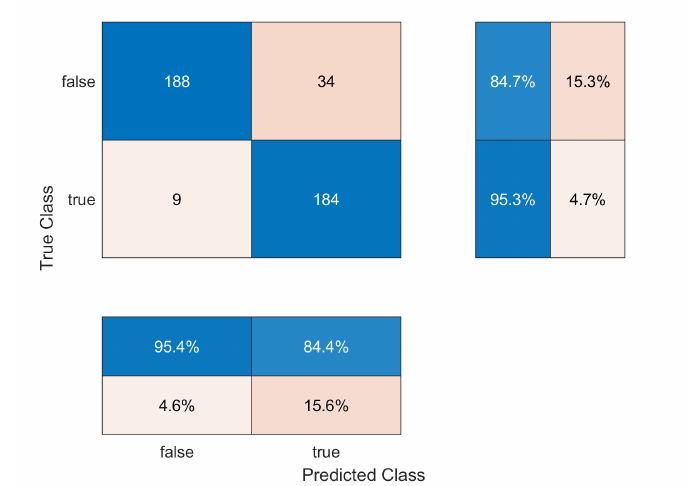
Figure 5. Confusion matrix (ItalianPVS